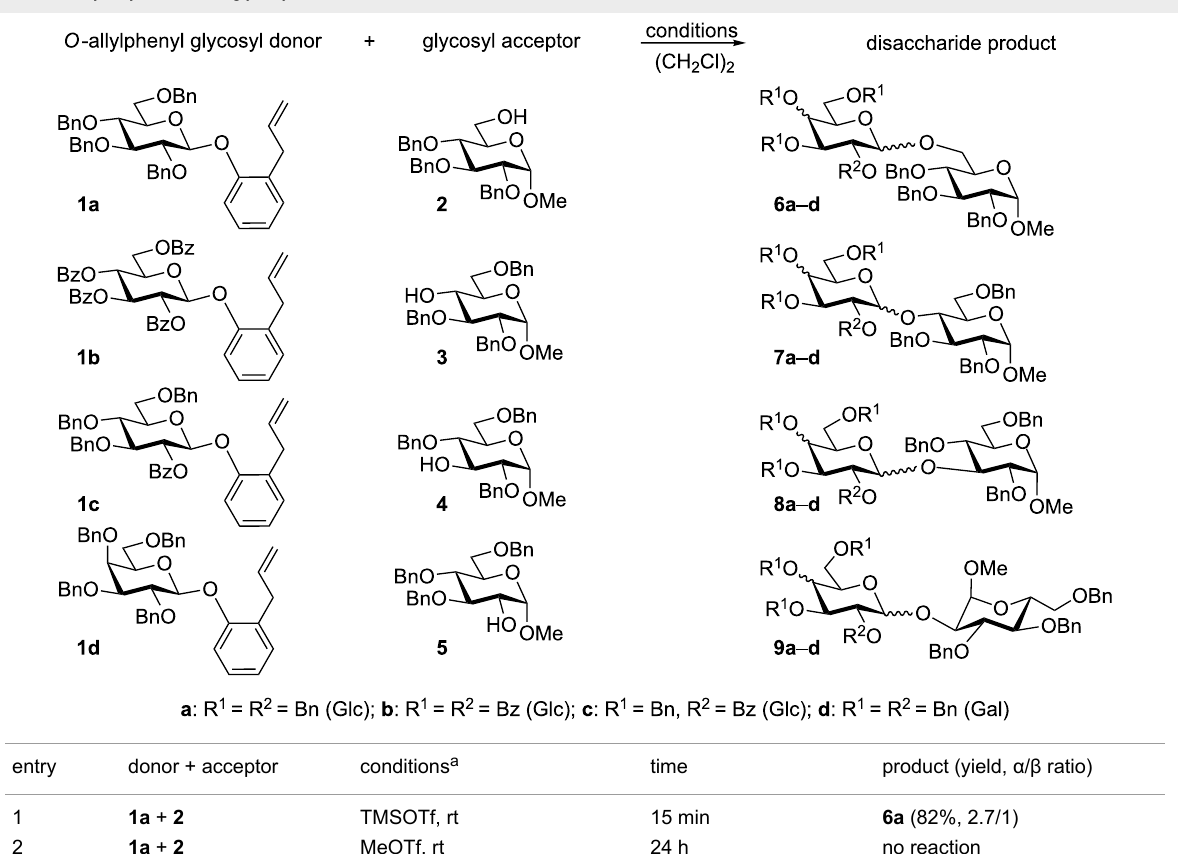
Table 1: Glycosylation of AP glycosyl donors 1a – d